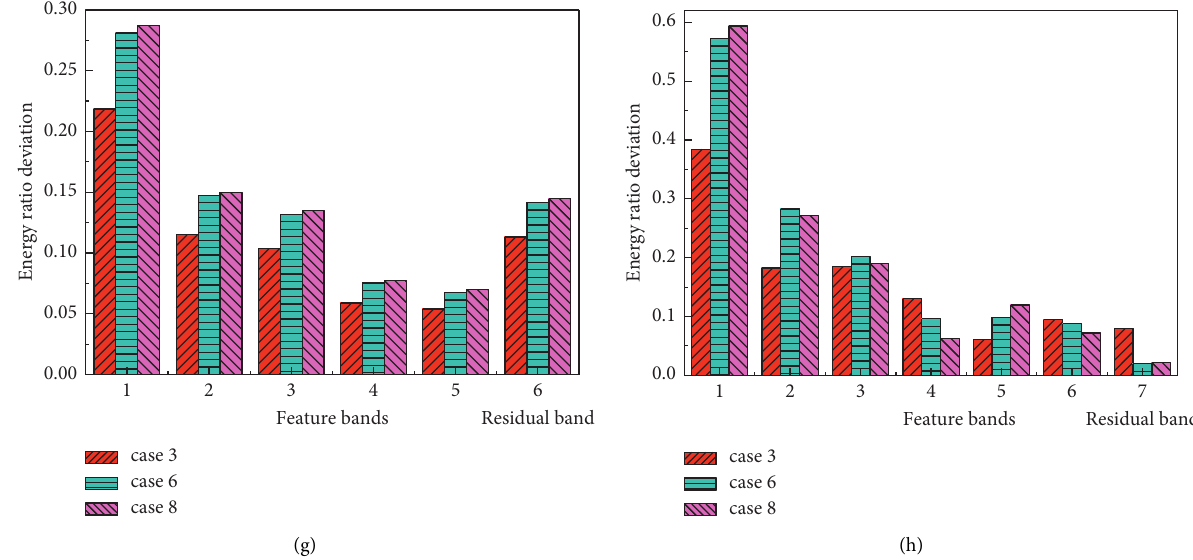
Figure 8: The Hilbert damage feature vector of IRF and VIRF (the second time test at excitation point I). Point 1: (a) IRF. (b) VIRF. Point 7: (c) IRF. (d)VIRF. Point 12: (e) IRF. (f) VIRF. Point 25: (g) IRF. (h) VIRF.